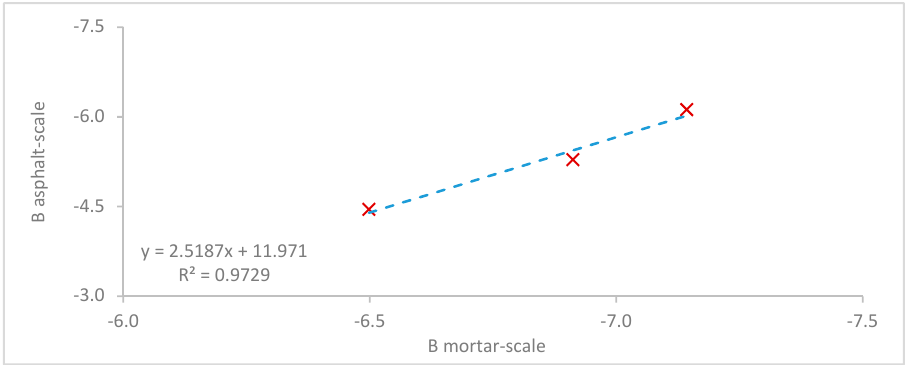
Figure 10. Relationship between the slopes (B) derived from the mortar- and the asphalt-scale fatigue tests.